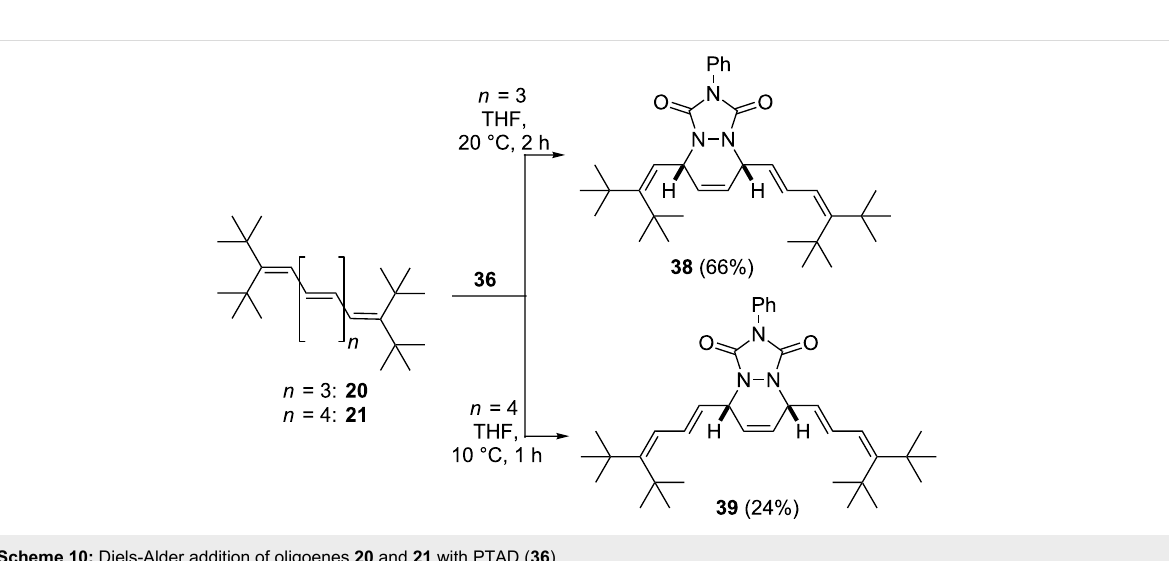
equivalent of PTAD. The course of the reaction in the latter case is more difficult to follow. Whereas 37 and 38 are color- less, cycloadduct 39 is yellow. In the former cases the reactions can be followed visually analogous to a titration, with the intensely colored PTAD serving as the indicator. In case of the